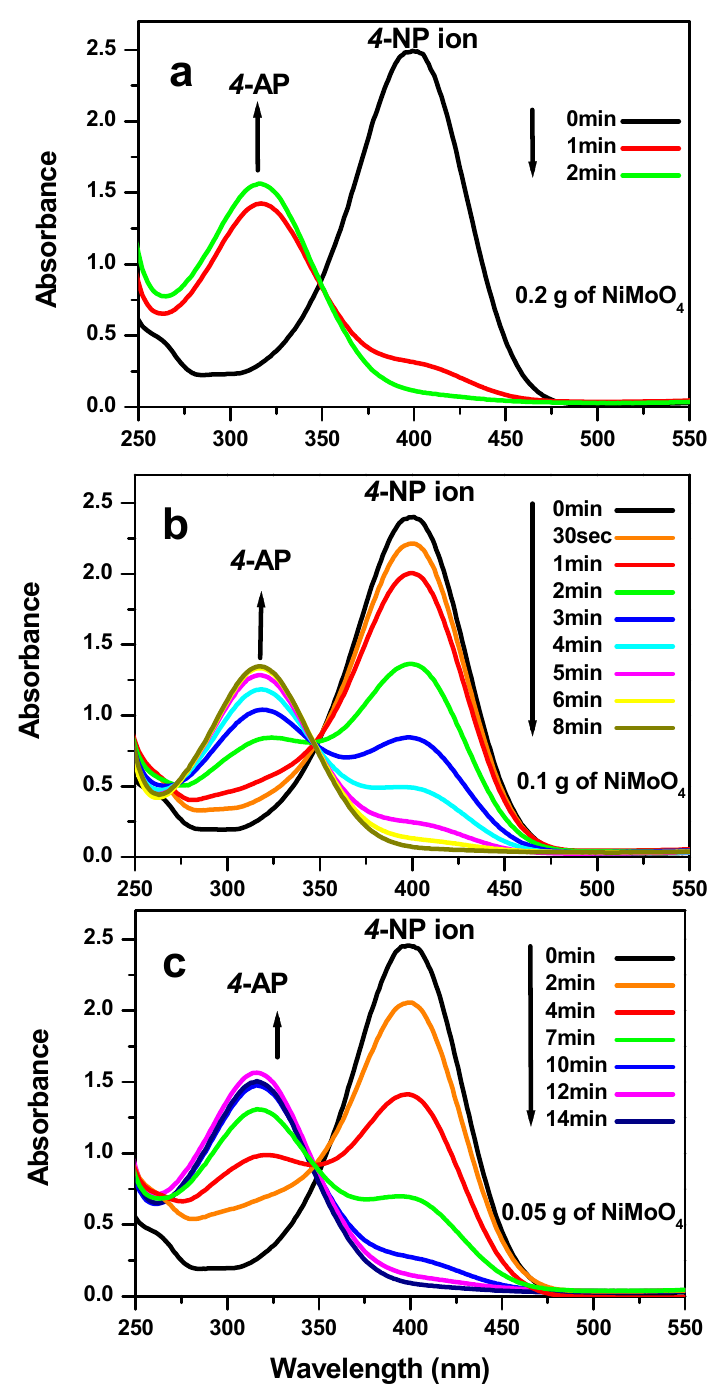
Figure 8. UV–vis spectra of reduction reaction for 4-nitrophenol using different amount of nickel molybdate, NiMoO 4 , ( a ) 0.20 g; ( b ) 0.10 g; and ( c ) 0.05 g at room temperature.